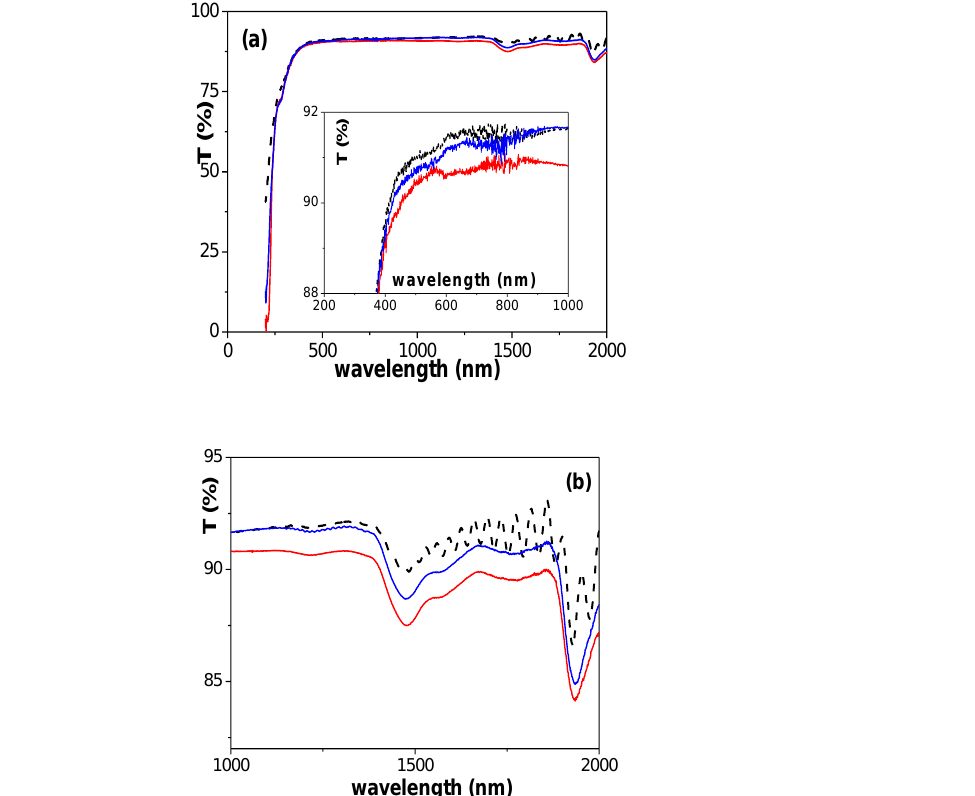
Figure 5. Light transmission as a function of wavelength: ( a ) for the whole range studied; ( b ) for the near-infrared region, for the RC/BMIMPF 6 film (red solid line), the RC/AliquatCl film (blue solid line) and the RC-support (black dashed line).